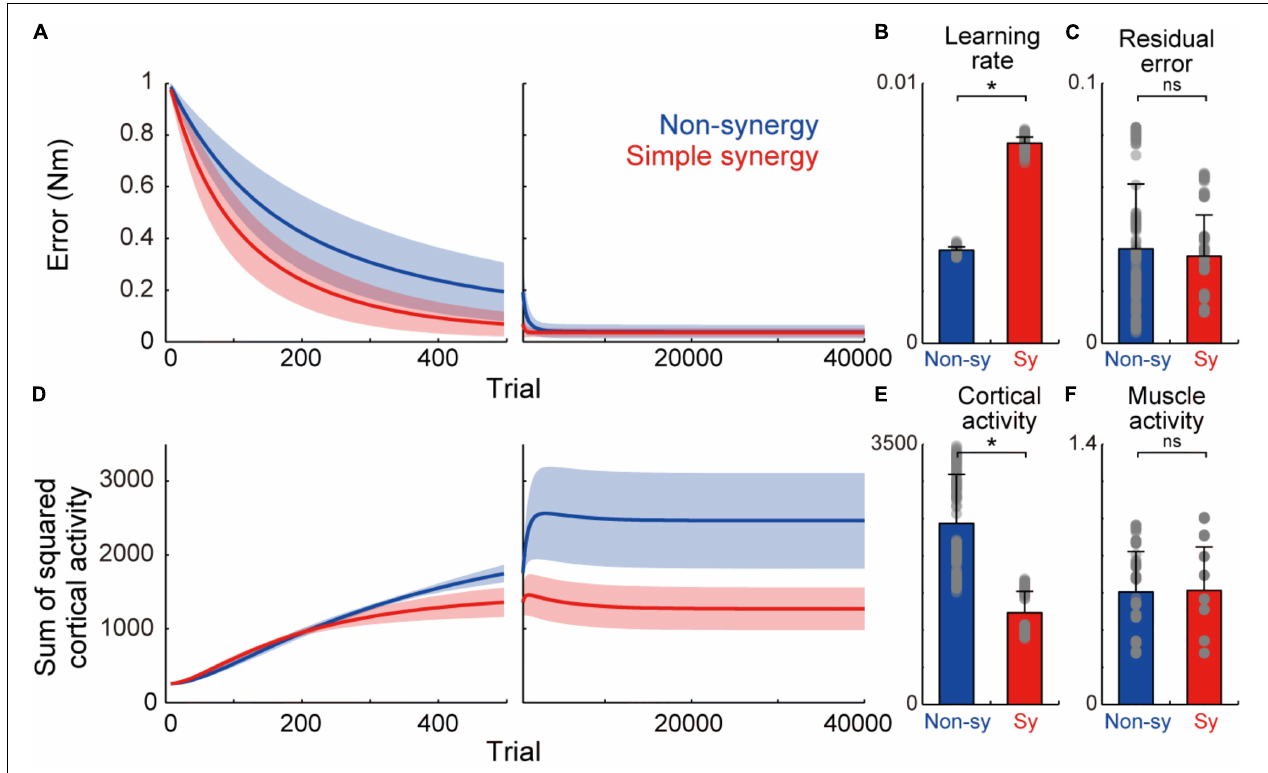
FIGURE 2 | Learning performance of non-synergy and simple synergy models. (A) Trial-dependent changes in the error magnitude for non-synergy (blue) and simple synergy model (red). Line and shade, mean and standard deviation across the simulations ( n = 200). Trials of each set of eight targets were averaged for presentation purpose. (B) Averaged learning speed calculated by fitting of an exponential curve. Gray dots, each simulation. Error bar, standard deviation. (C) The same format but for residual error at the end of the training. (D) The same format but for the sum of squared cortical neural activity. (E,F) The same format but for the sum of squared activity of cortical neurons (E) and muscle activity (F) at the end of training. * p < 0.05; ns, non-significant; bootstrap test, n =